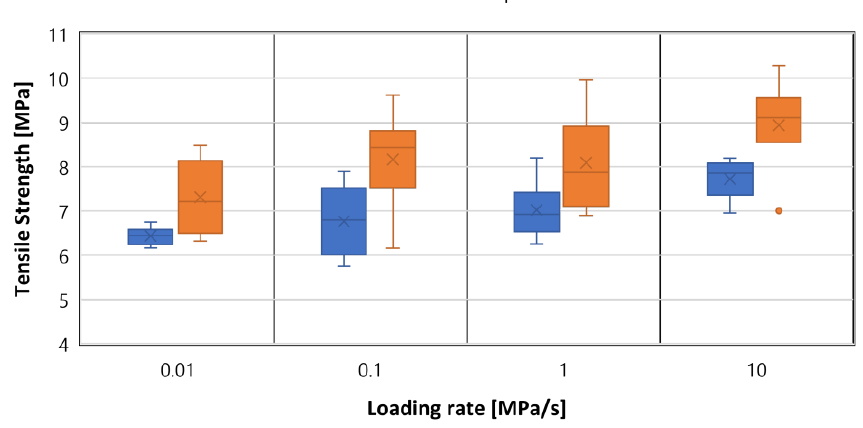
Figure 9. Comparison of the tensile strength between the Brazilian tension and three-point flexural tests.